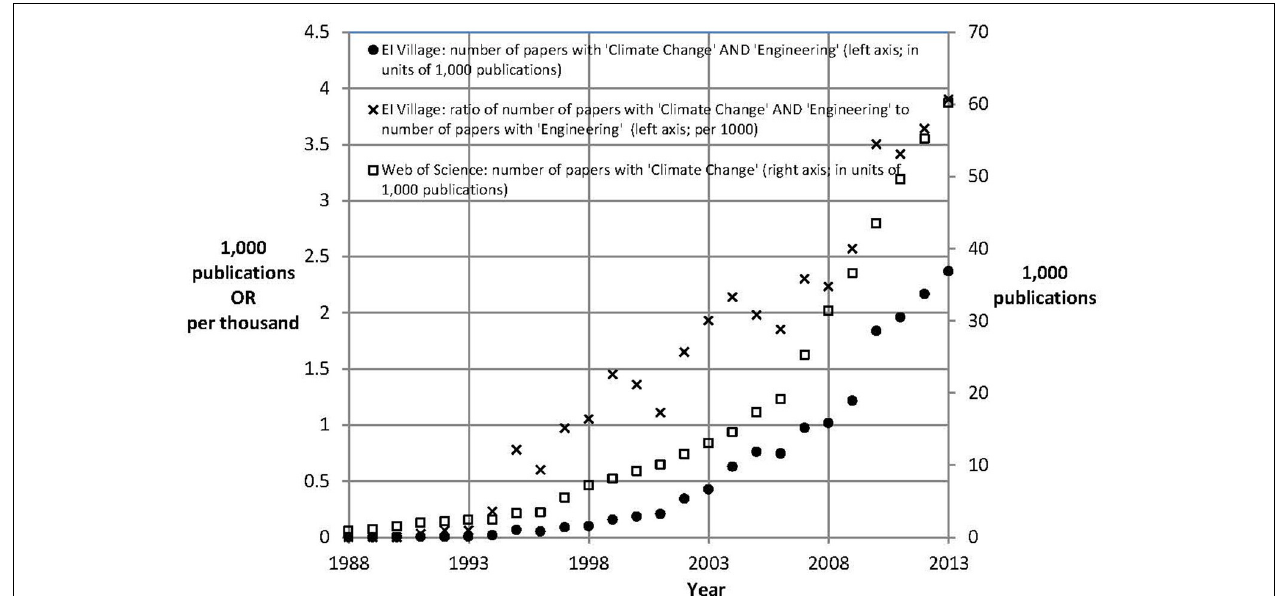
FIGURE 1 | Trendsinnumberofpublicationsmakingreferencestoclimate change in the engineering field from El Village, and in science generally from Web of Science (search conducted on 16 July 2014 and covered the